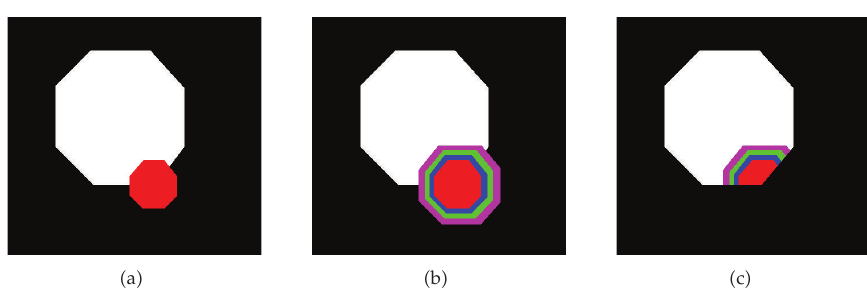
Figure 4: (cid:2) a (cid:3) Marker set S i (cid:2) in red (cid:3) and mask set S i (cid:8) 1 (cid:2) in white (cid:3) , (cid:2) b (cid:3) after iterative dilations up to fourth level superposed on the mask set S i (cid:8) 1 , and (cid:2) c (cid:3) the dilated marker set for four iterations intersected with mask set S i (cid:8) 1 .